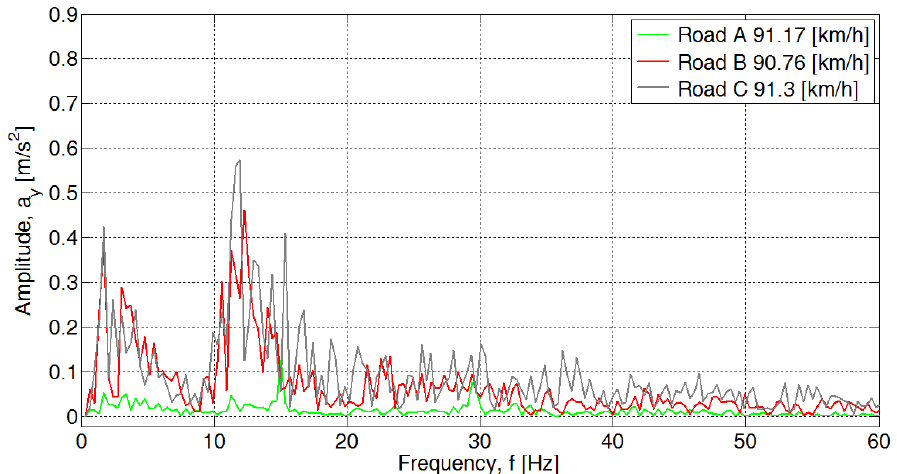
Figure 9. Amplitude of the body accelerations in the longitudinal direction for a selected random window for a given speed (x axis), for test surface conditions A, B and C.